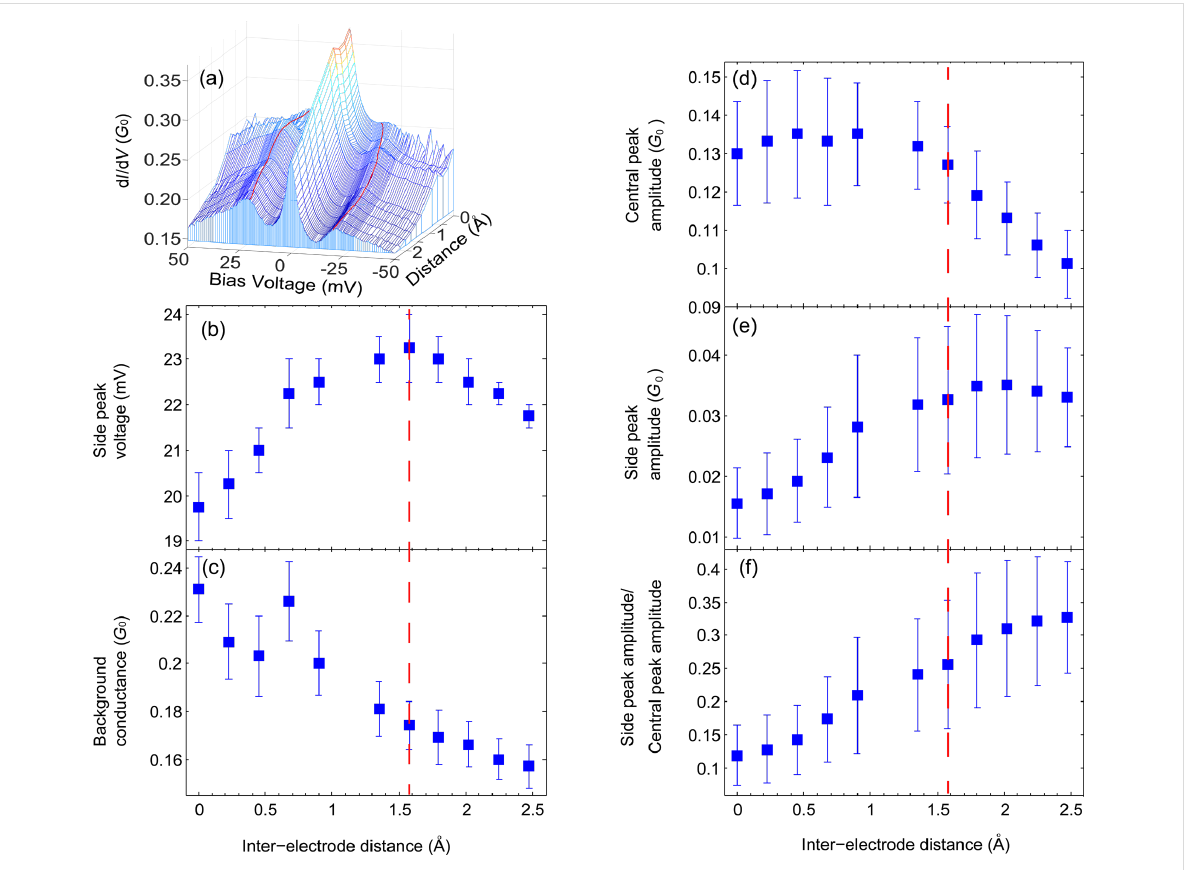
Figure 2: (a) Differential conductance curves measured during the elongation process of the junction. The red lines are a guide to the eye outlining the changing trend of the voltage shift of the side peaks. Average side peak voltage (b), background conductance (c), central peak amplitude (d), side peak amplitude (e), and normalized side peak amplitude (f) as a function of inter-electrode distance. The different parameters were obtained by fitting Lorentzian functions to the zero and finite bias peaks. The background conductance was considered as the conductance at 50 mV, far from the peak features. The stretching dependence was observed in more than 30 junctions, all of which showed a 3–5 mV shift in the position of the finite-bias peaks. The full span of the non-monotonic shift was observed for four